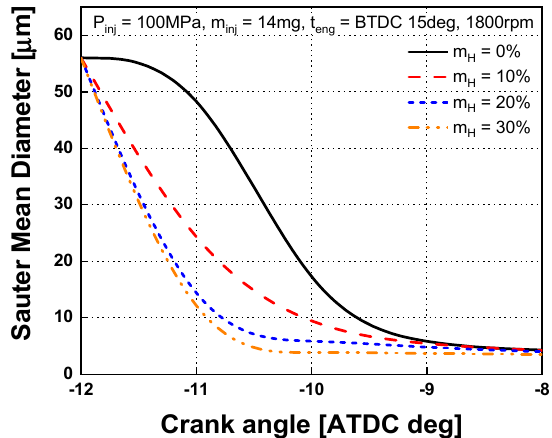
Figure 6. Effect of water vapor portion on the Sauter mean diameter (SMD). P inj = 100 MPa, m inj = 14 mg, t eng = BTDC 15deg, 1800 rpm.